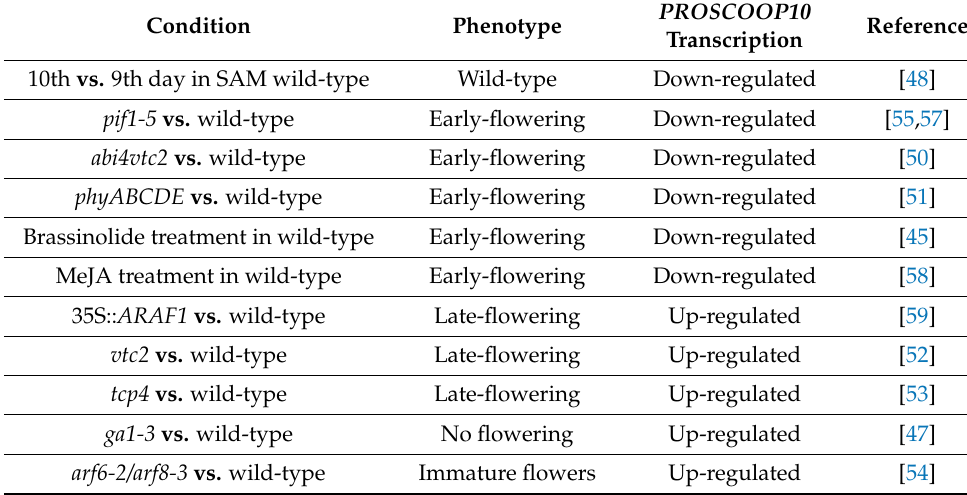
Table 1. Expression profiles of the PROSCOOP10 genes extracted from public